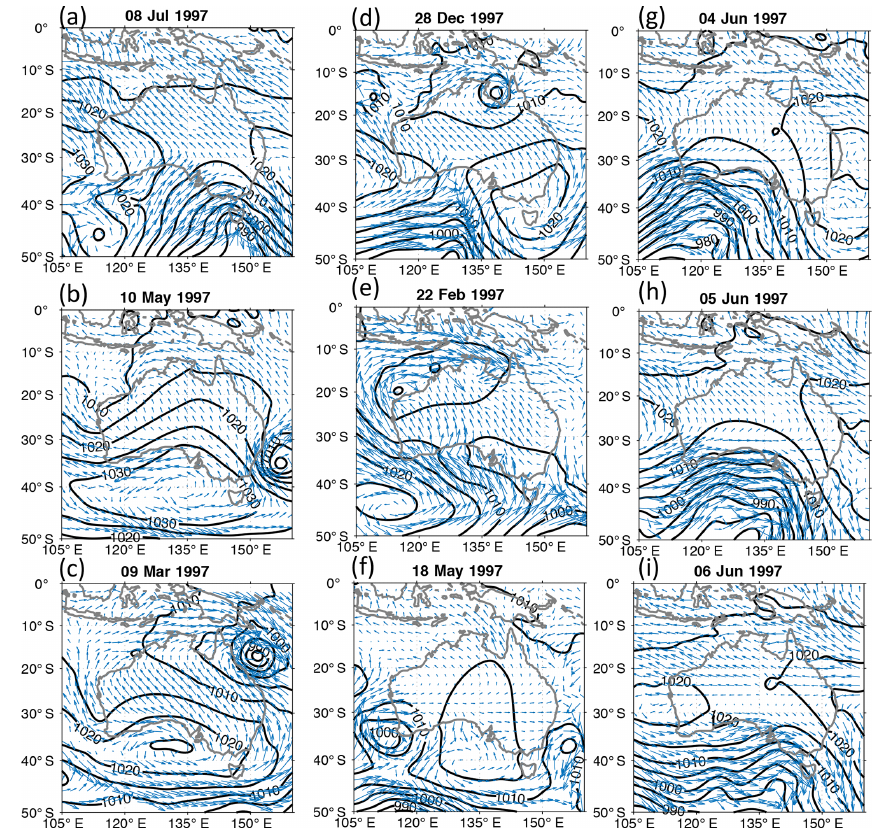
Figure 5. Mean sea level pressure and surface winds from CFSR reanalyses associated with the storm surge events indicated with black arrows in Fig. 3. Note, Fig. 3i and j both relate to the same synoptic pattern as Fig.